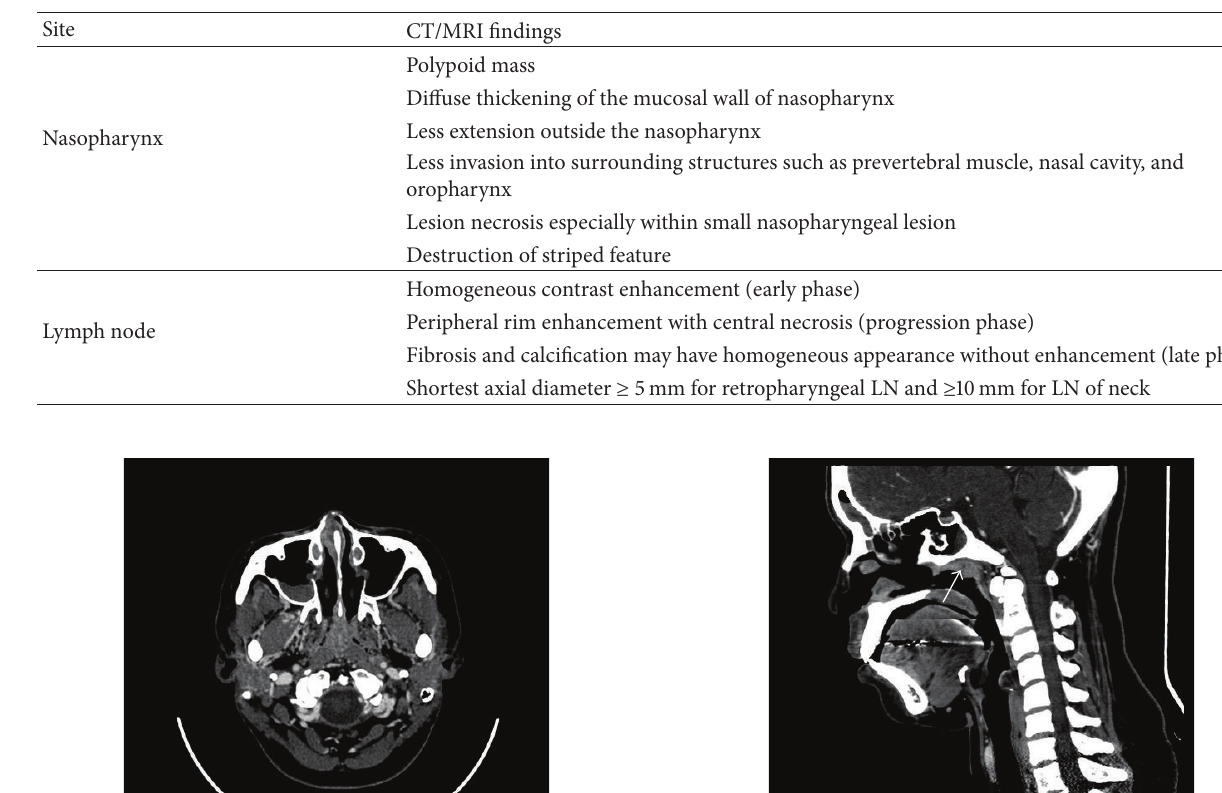
Table 4: Summary of CT/MRI findings [10, 44].